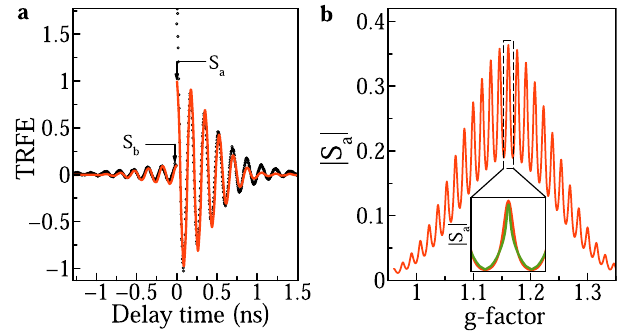
Fig.3|CalculationofspinpolarizationandTRFEsignal.a Time-resolvedFaraday ellipticity (dots) measured at B V =0.35 T and its modeling (red line). b Spectral distribution of precessing modes for T 2 =28 ns. Inset: illustration of precessing mode with NIFF for T 2 =13 ns (green) and without NIFF for T 2 =28 ns